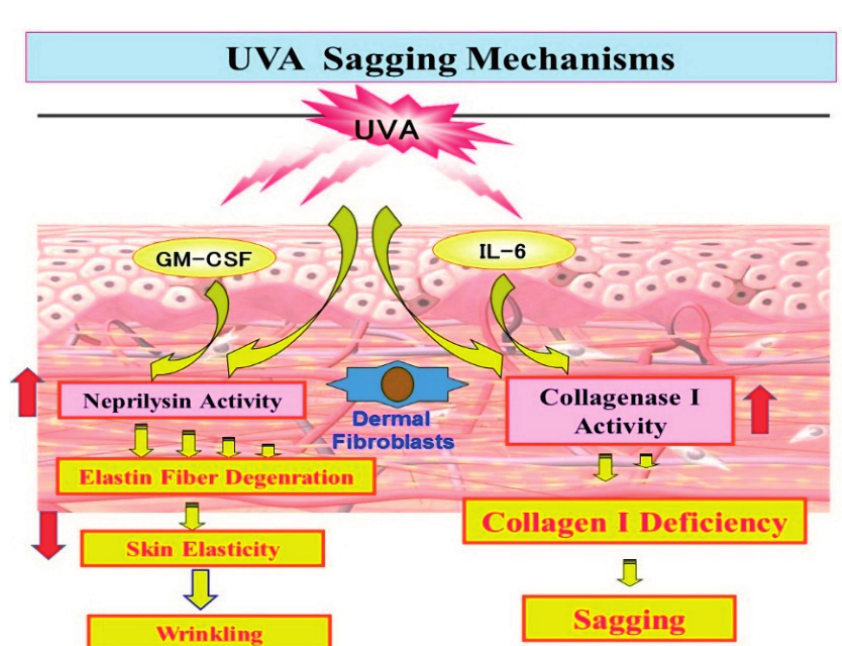
Figure 13. UVA sagging